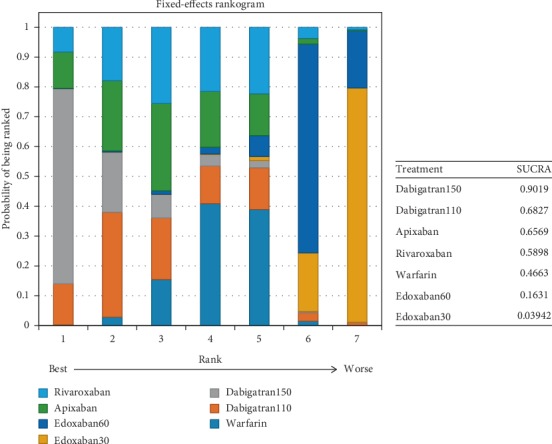
Ranking plots for the efficacy of the comparison among different treatments of patients with normal renal function (ranking indicates the probability to be the best treatment, the second best, the third best, and so on).